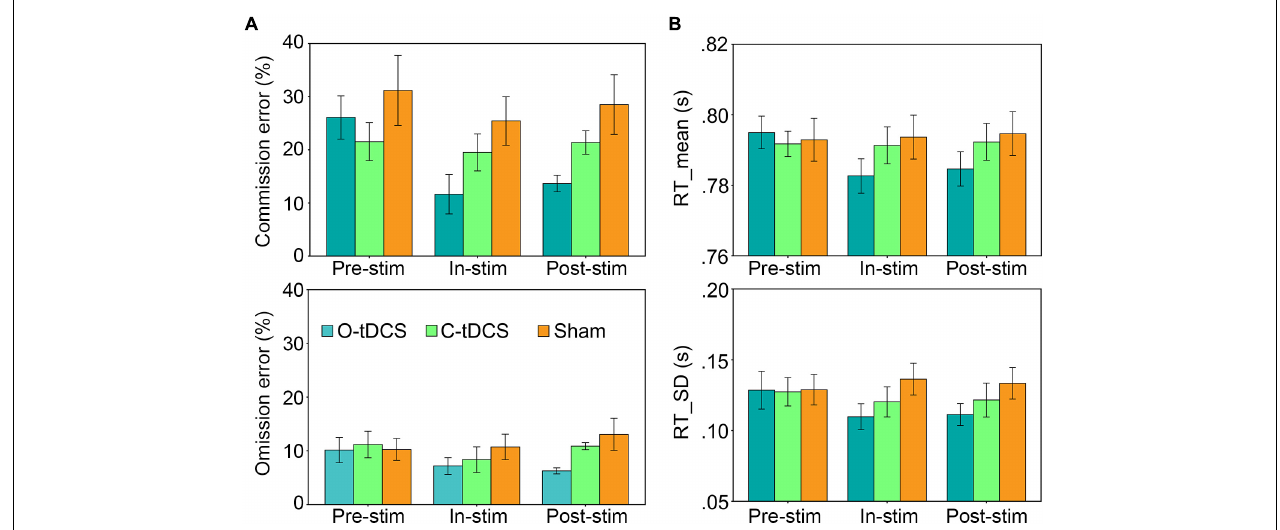
FIGURE 2 | The oscillatory transcranial direct current stimulation (O-tDCS) improved accuracy and reduced the mean and SD of reaction time (RT) under pre-stim, in-stim, and post-stim. (A) Accuracy. (B) RT. Error bars show the 95% confidence interval. TABLE 1 | The ANOVA results for all